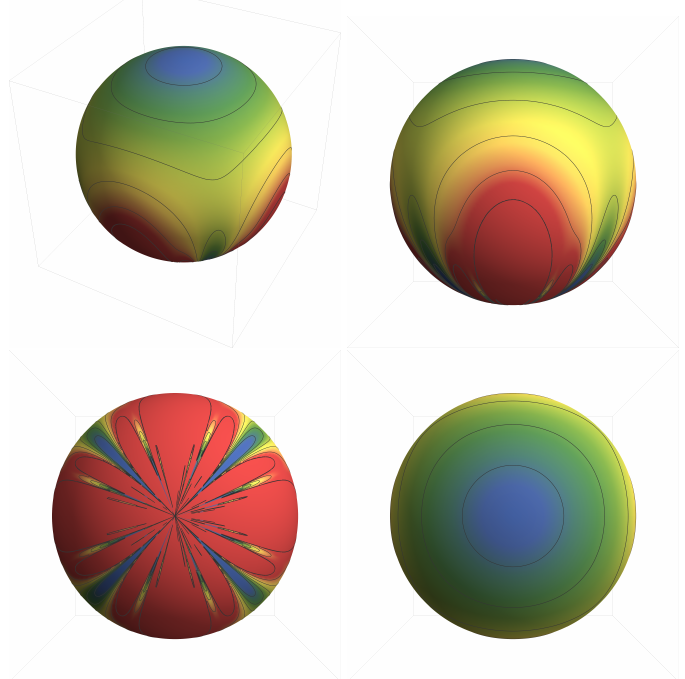
Figure 5. Various viewpoints of the whole sphere mapping of L ( C ( 4 ) ; z ) for the case of | f 12 ( z ) | . The natural boundary is mapped to the south pole and is seen most clearly in the bottom left